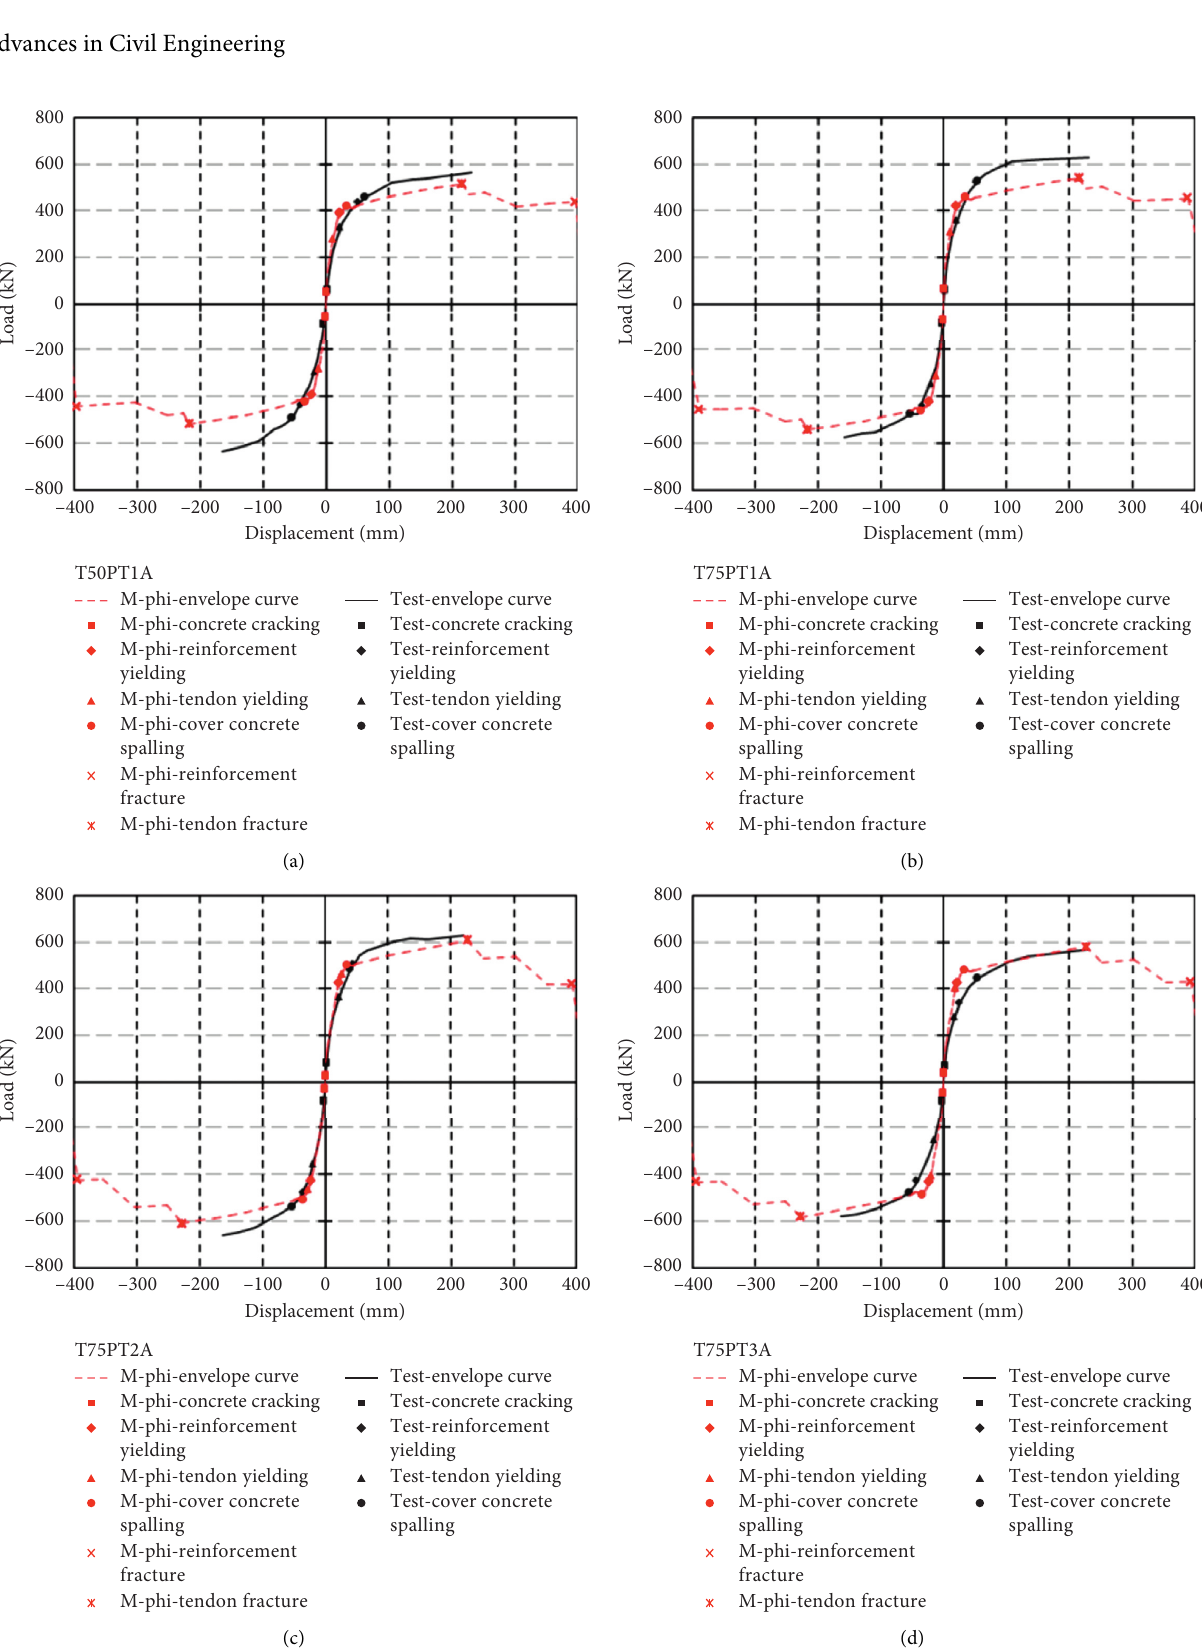
Figure 13: Load–displacement envelope curves from test and M-Phi analysis result. (a) T50PT1A. (b) T75PT1A. (c) T75PT2A. (d)